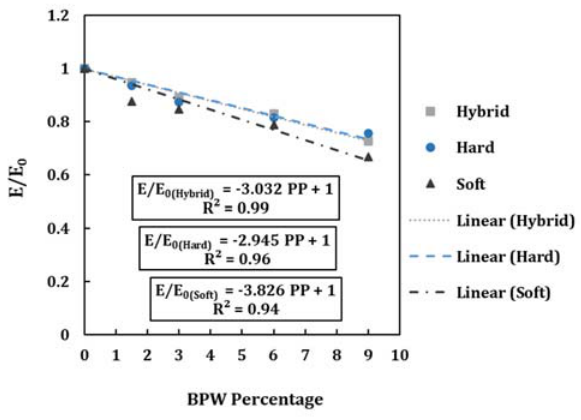
Figure 14. The modulus of elasticity ratio of BPW-containing concrete to control concrete versus BPW percentages.